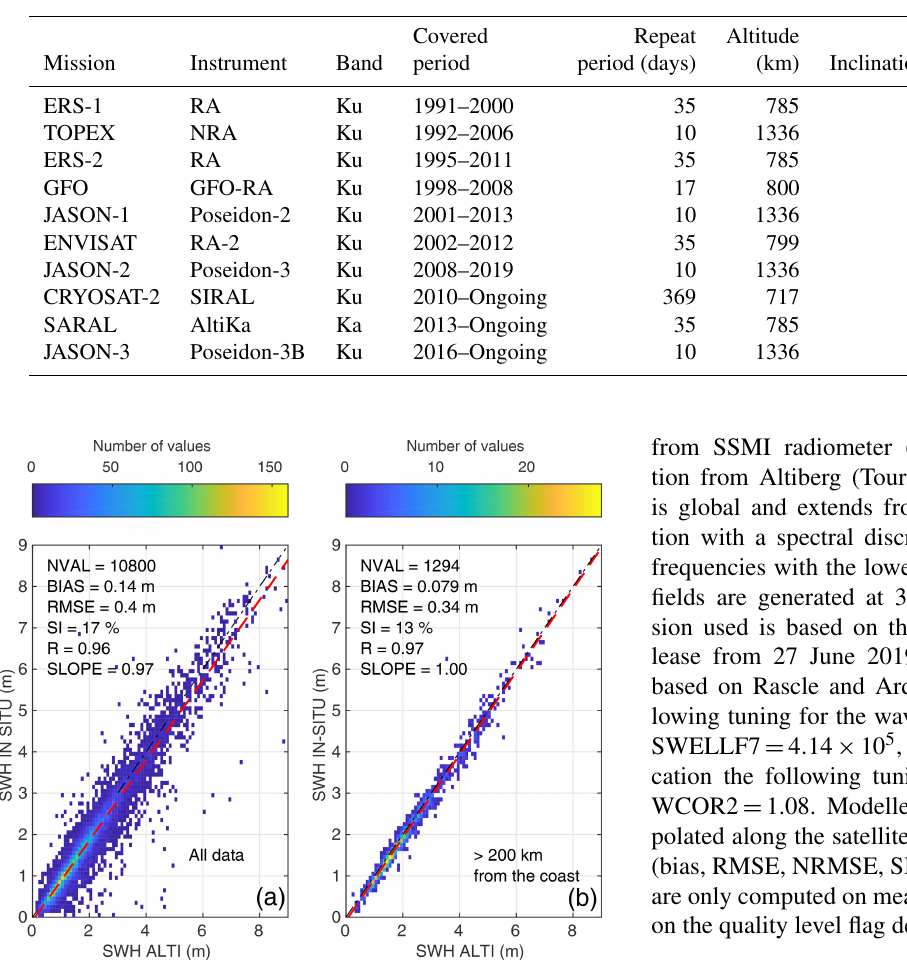
Table 1. Characteristics of altimeter missions used for the Sea State CCI dataset v1.